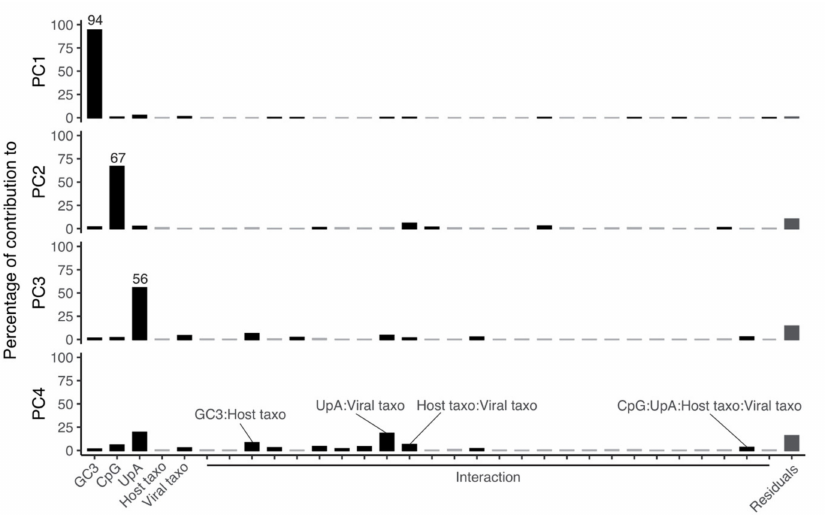
Figure 4. Linear model quantifying the relative contribution of the different variables to the projec- tions of the first four main dimensions of the synonymous codon usage PCA (Figure 1A). Variables included in the linear model are: GC3-content, observed/expected frequency of the CpG dinu- cleotide, observed/expected frequency of the UpA dinucleotide, host taxonomy at the level of family, viral taxonomy at the level of genus, and all their pairwise interactions. Statistically significant contributions are shown as black bars, stating the percentage of the total explanatory contribution to the correspondent PCA